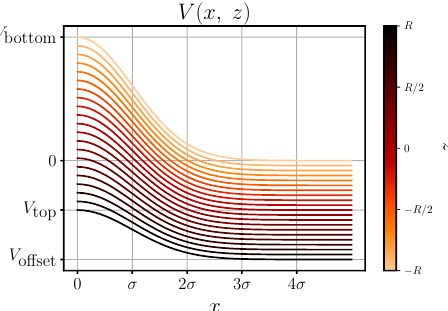
= − 30 meV, V = 25 meV, top bottom